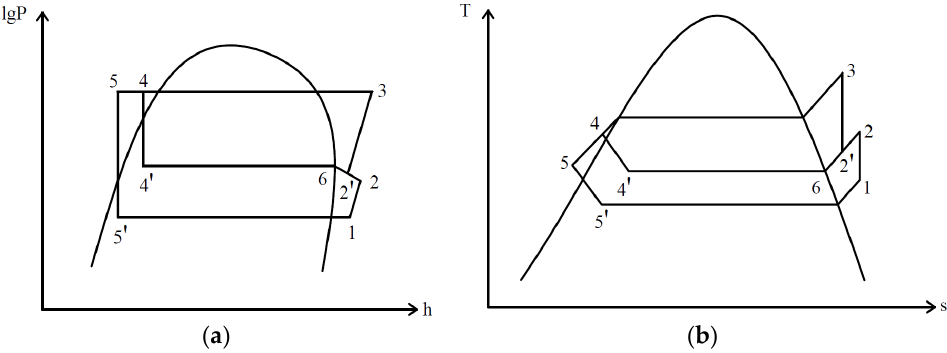
Figure 2. Double evaporator heat-pump drying system refrigeration cycle: ( a ) P-h; ( b ) T-s.